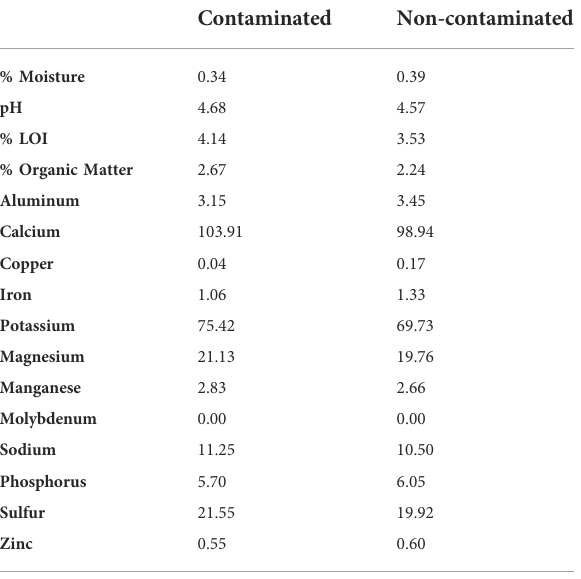
TABLE1Soilqualityanalysisforcontaminatedandnon-contaminated